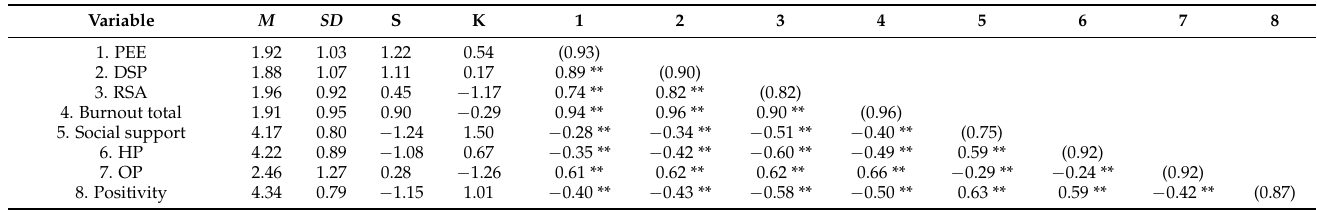
Table 1. Descriptive statistics, internal reliabilities and correlations for